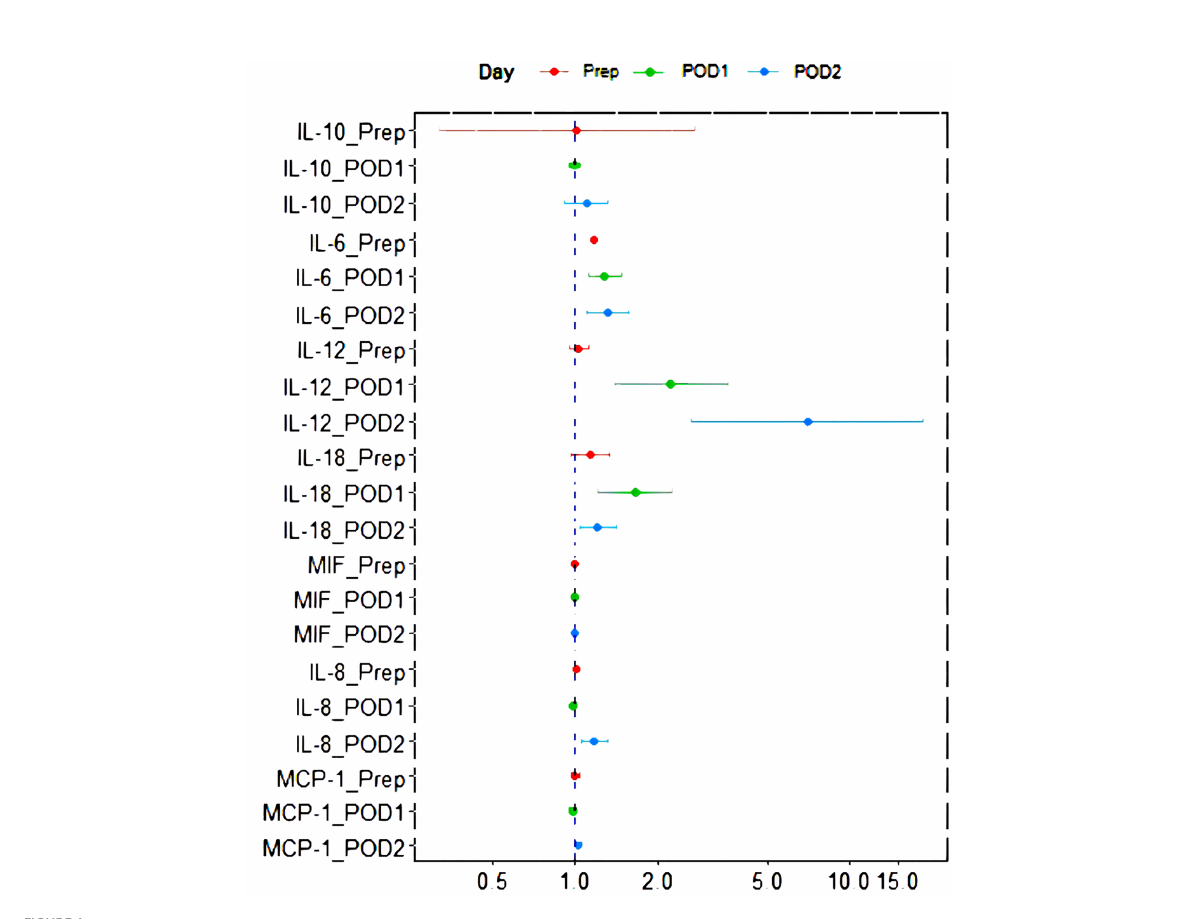
FIGURE 1 Forest plot of the relationship between perioperative in fl ammatory factor expression and postoperative infection outcome after the adjustment of operating time and low blood pressure in operation. IL, interleukin; MCP-1, monocyte chemoattractant protein; MIF, macrophage migration inhibitory factor; POD1, 0-hour post-operation; POD2, 24-hour post-operation; Prep,